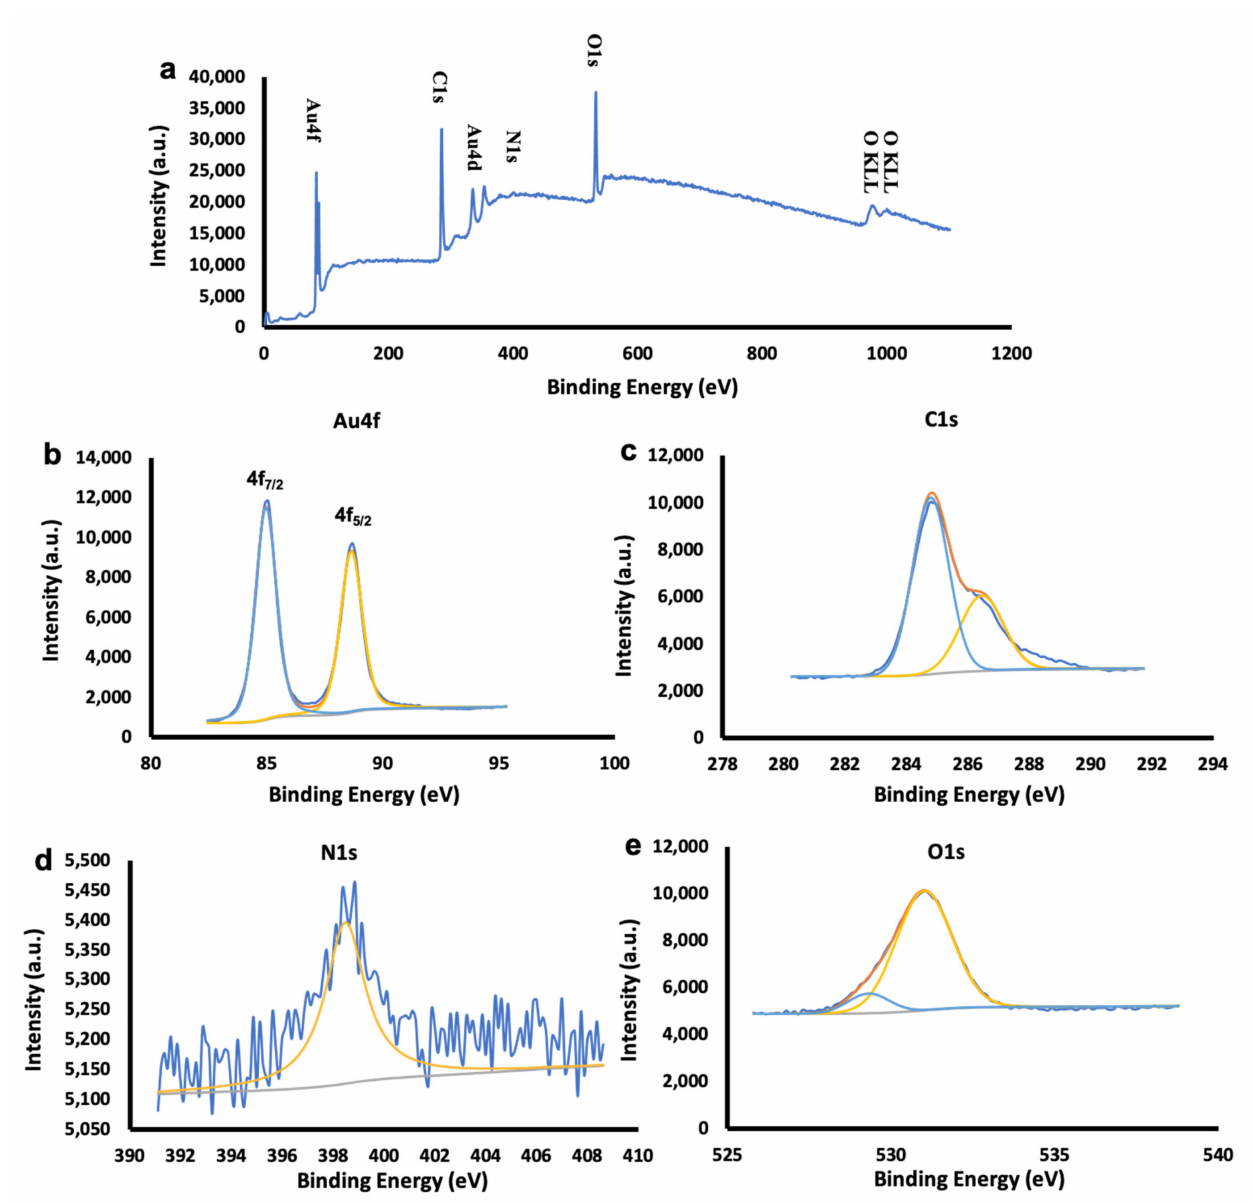
Figure 3. XPS analysis of Ch-AuNPIV ( a – e ). ( a ) Wide spectra, ( b ) Au spectra, ( c ) carbon spectra, ( d ) nitrogen spectra and ( e ) oxygen